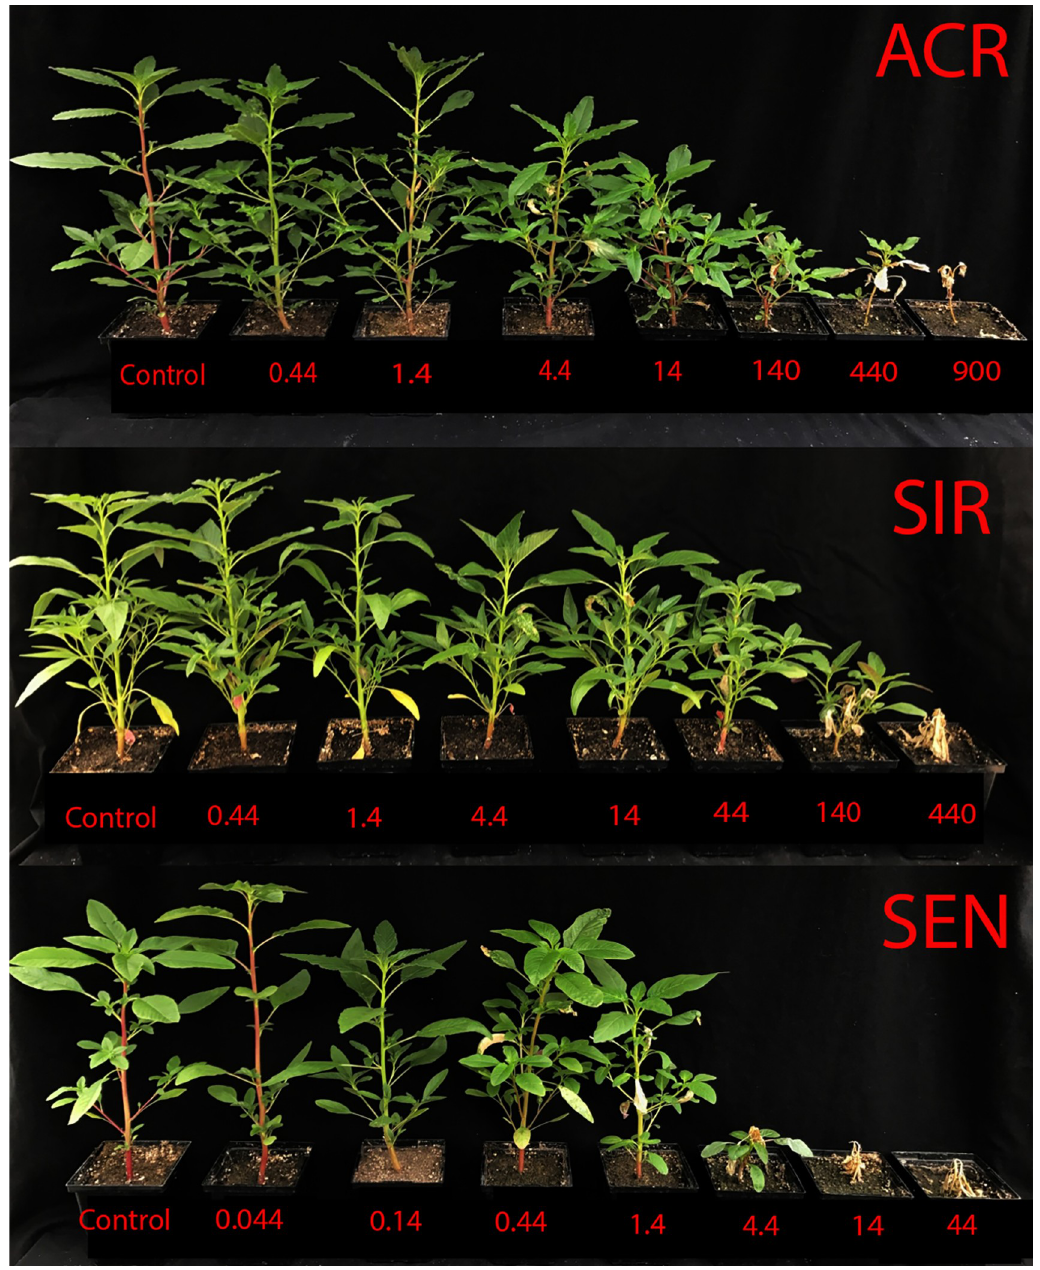
Fig 2. Carfentrazone-ethyl (CE) dose-response study with the ACR, SIR, and SEN populations at 10 DAT. The rates of CE (plus adjuvants) applied when seedlings were 9–11 cm tall are listed below each pot in g ai ha -1 , while control plants were only treated with 1% (v/v) COC and 2.5% (v/v) AMS. The field-use rate for CE is 14 g ai ha -1